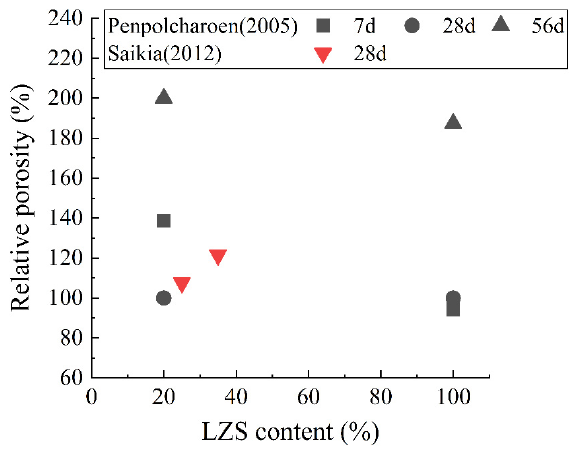
Figure 10. Relative porosity of hardened paste containing LZS aggregate [66,89].